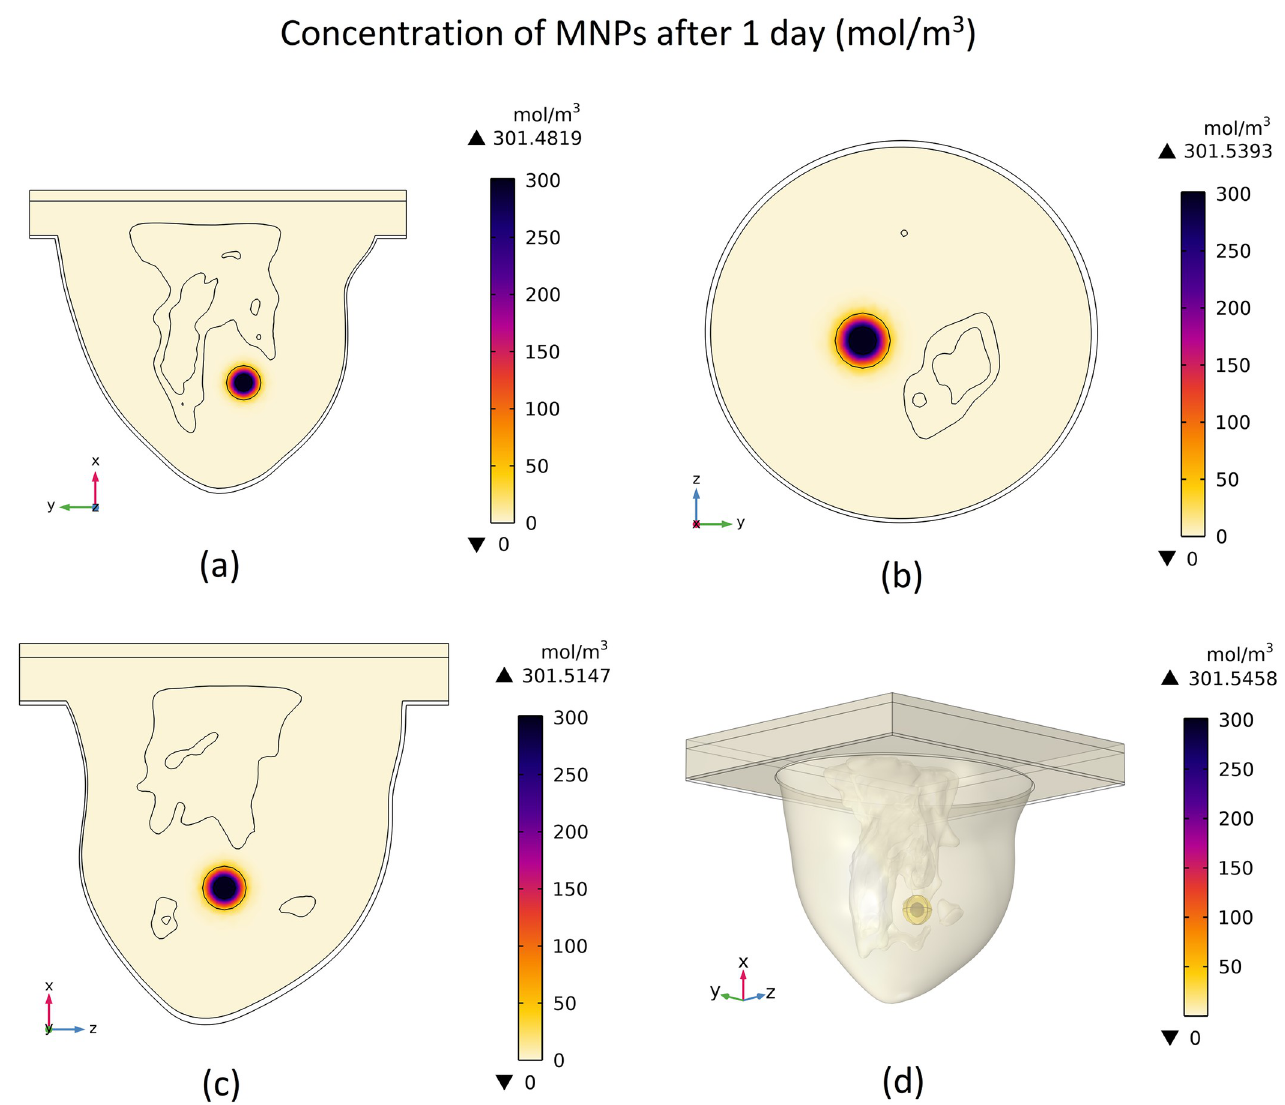
Fig 12. Distribution of MNPs’ concentration after 1 day of diffusion, (a) cut surface 1, (b) cut surface 2, (c) cut surface 3, (d) 3D view.